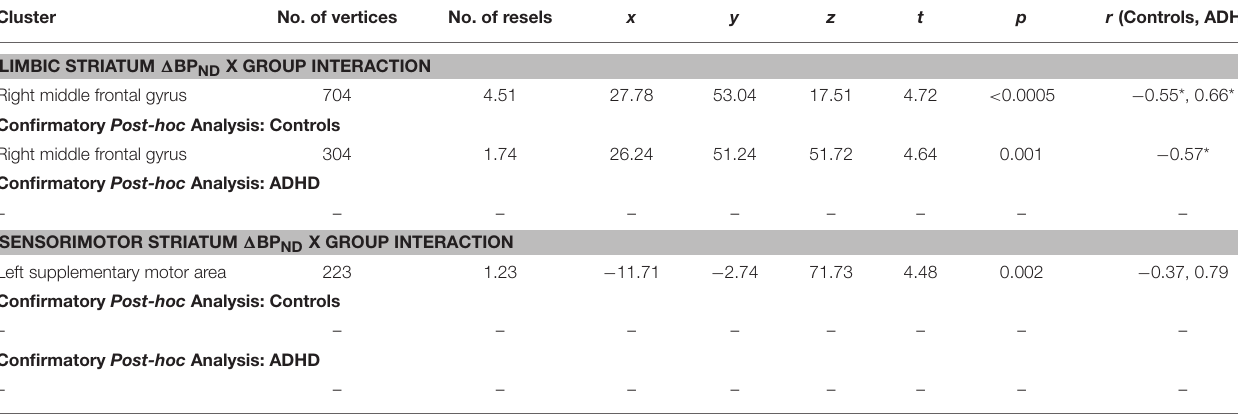
TABLE 3 | d -Amphetamine induced change in BP ND in relation to cortical thickness. Cluster No. of vertices No. of resels x y z t p r (Controls, ADHD)